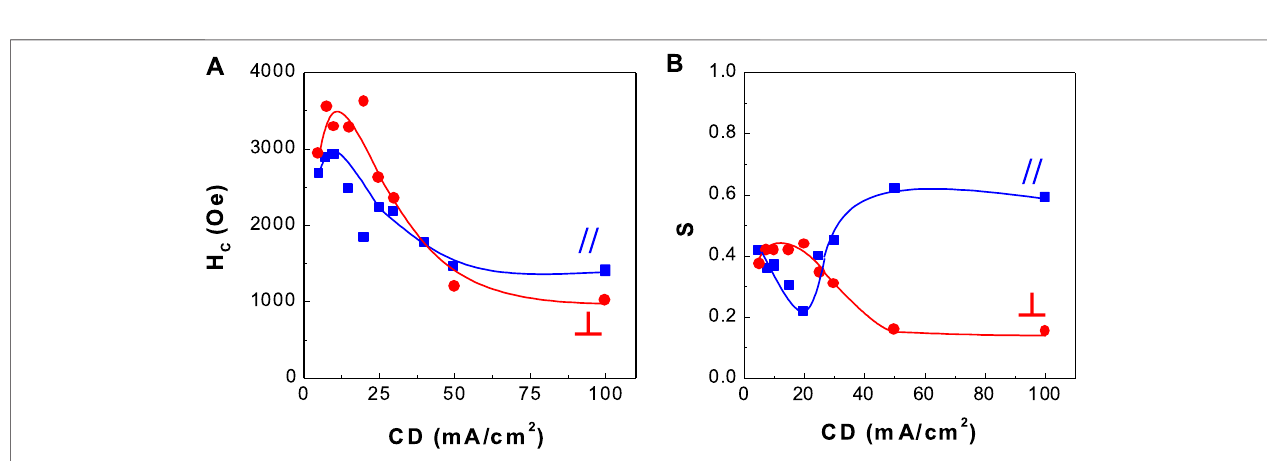
FIGURE 8 | Dependence of coercivity and squareness of CoPtP thin fi lms on current density (CD) (A) coercivity and (B) squareness.